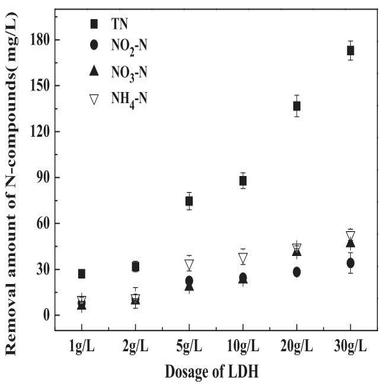
Removal of N-compounds with different dosage of AC and Ca (OH)2. from the AC.